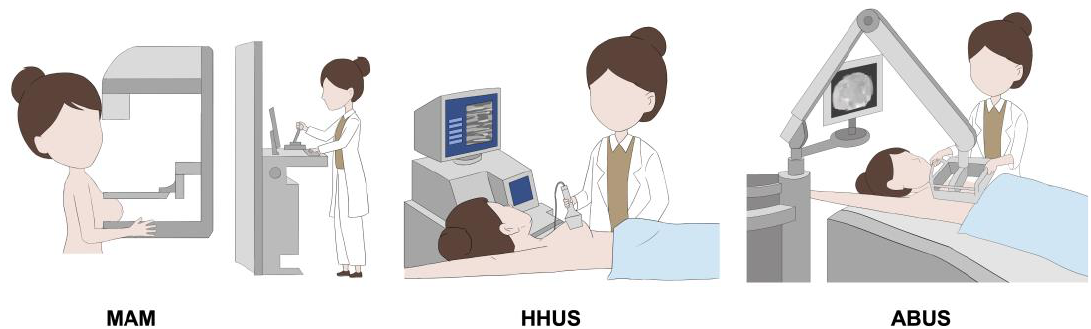
Figure 1. The schematic illustration of MAM, HHUS, and ABUS.